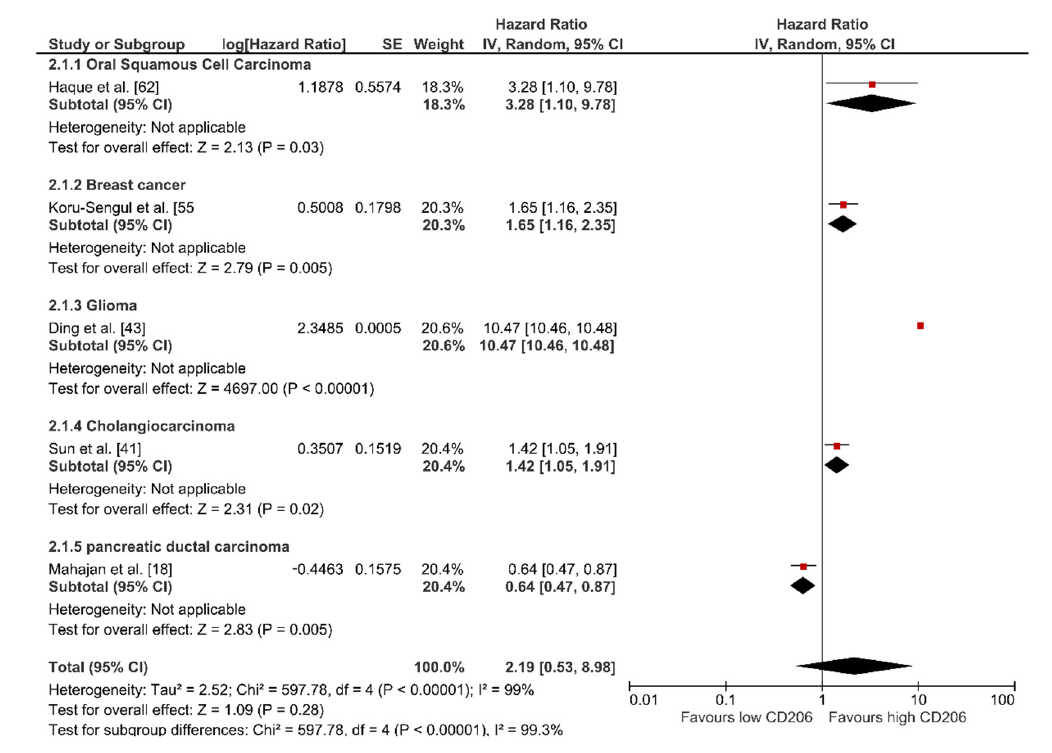
Figure A2. Forrest plot of impact of CD206-expression on the progression-free survival of patients diagnosed with solid cancers. SE: standard error; IV: Interval variable; CI: confidence interval; df: degrees of freedom.